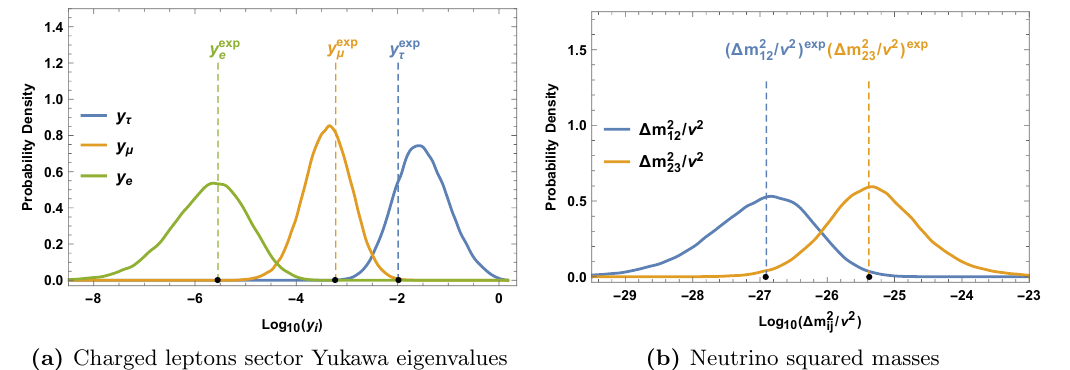
(b) Rephasing invariant